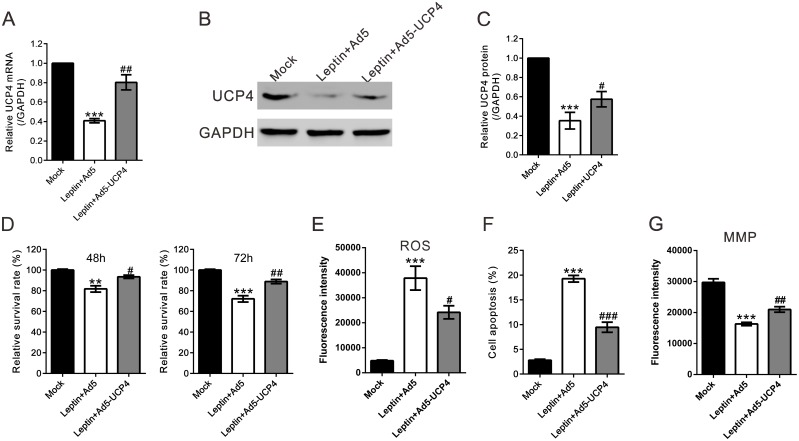
Ectopic expression of UCP4 reversed the effects of leptin on the proliferation and apoptosis of chondrocytes.Rat chondrocytes were infected with control adenovirus (Ad5) or UCP4 adenovirus (Ad5-UCP4) in the present of 20 ng/ml leptin. (A, B, C) At 48 h after treatment, the mRNA and protein level of UCP4 of chondrocyte cultures was detected. (D) At 48h and 72h of treatment, cell survival was analysis with CCK-8 assay. (E, F, G) At 48 h after treatment, ROS, cell apoptosis and MMP was analyzed. **P<0.01 and ***P <0.001 versus non-treated cells (Mock). #P <0.05, ##P<0.01 and ###P <0.001 versus 20 ng/ml leptin and Ad5-treated cells.